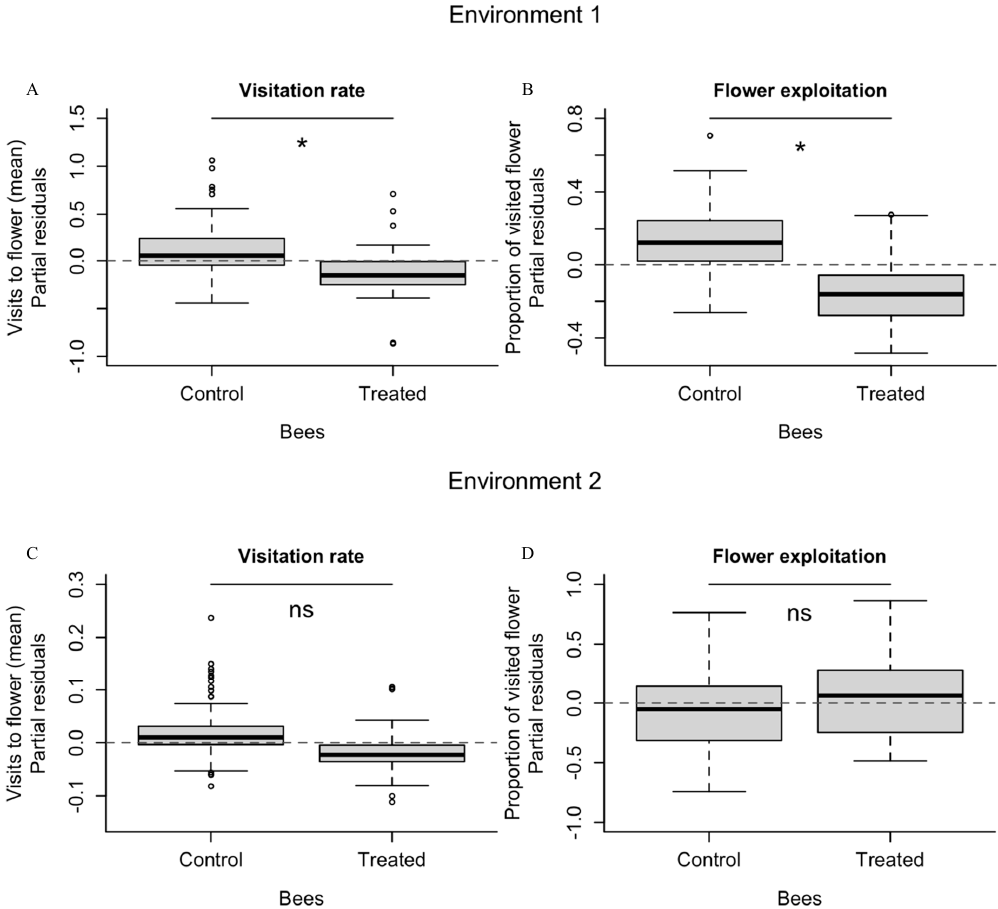
Figure 1. The solitary bee Osmia bicornis responded negatively to pesticide exposition in environment type 1. The visitation rate and the flower exploitation ( A-B ) of this bee species was significantly reduced after exposure to fenbuconazole compared to the control group. The negative effect was not observed in environment type 2 ( C-D ). * Statistically different ( α = 0.05); ns = not significant.